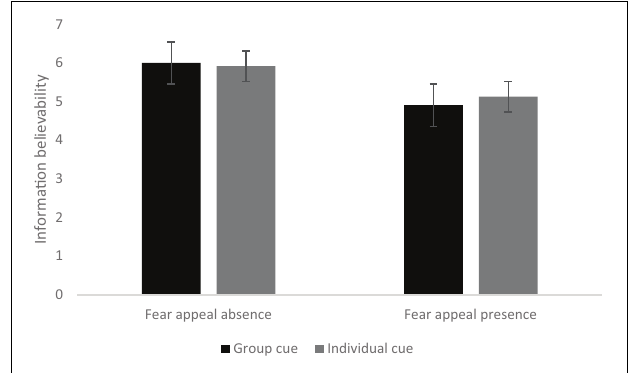
FIGURE 1 | The interaction effect of social norm appeals (individual vs. group cues) and fear appeals (absence vs. presence) on information amount.